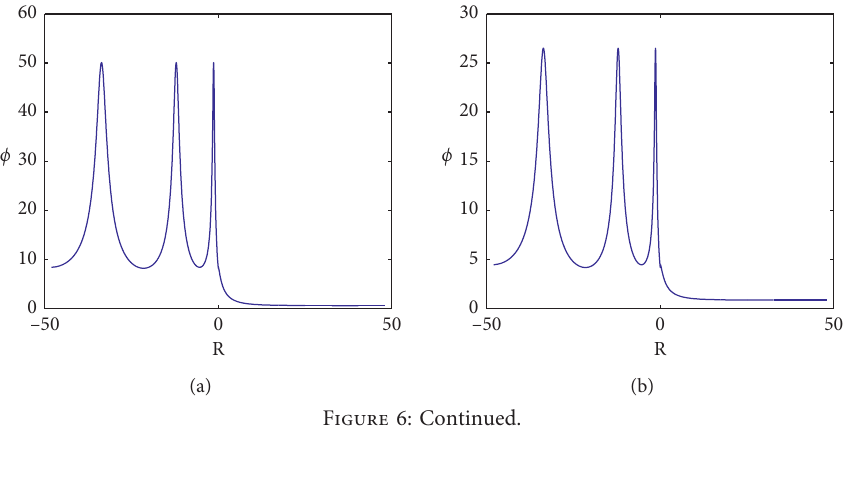
� 1 . 2, β � 1 . 4, λ � 1 . 3, ω � 1, and ϖ � 1. (b) β 1 3 � 1 . 2, β � 1 . 4, λ � 1 . 3, ω � 1, and ϖ � 1 3